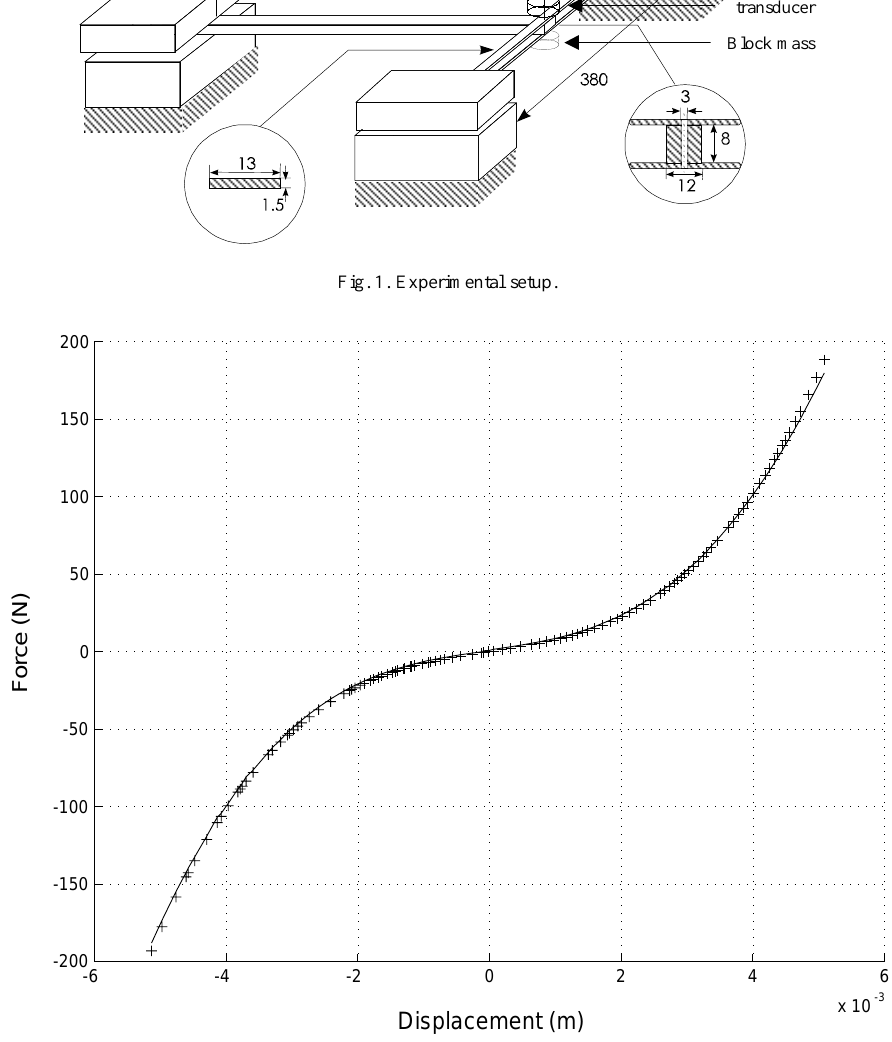
Fig. 2. Displacement-force characteristic for Beams